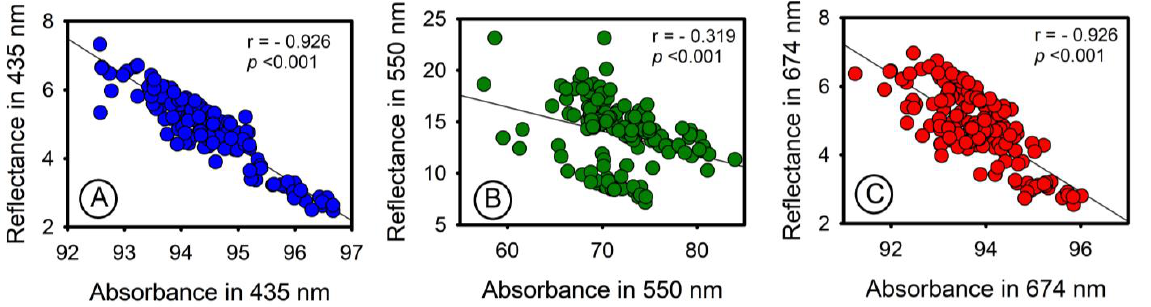
Figure 11. Pearson’s correlation between absorbance and reflectance specific points of the blue, green, and red bands selected in leaves. ( A ) Wavelength at 435 nm. ( B ) Wavelength at 550 nm. ( C ) Wavelength at 674 nm.